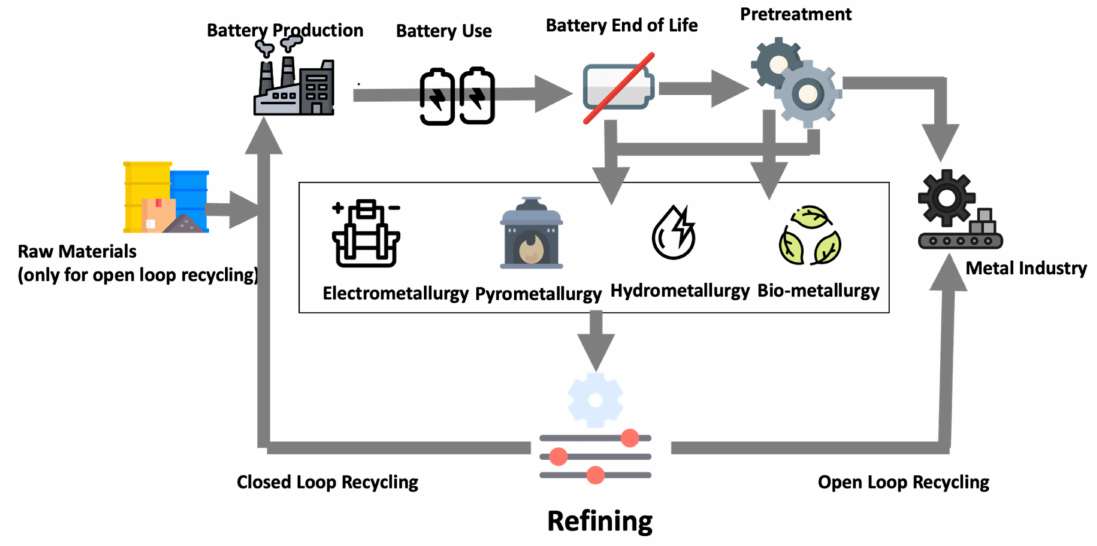
Figure 6. Conventional recycling stages for spent Li-ion